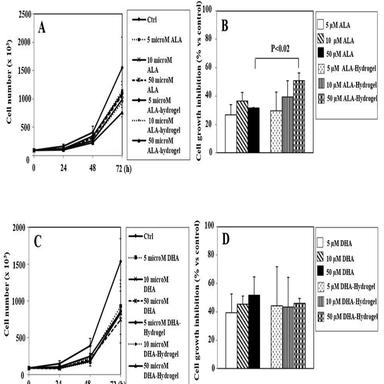
(A) Effect of ALA, in its free form, or delivered by hydrogel at increasing concentrations (5–50 μM) on the growth of HCT116 human colon adenocarcinoma cells evaluated at different time points (24–72 h). (B) Effect of a 72 h treatment with 50 μM ALA, in its free form or delivered by hydrogel, on the growth of HCT116 cells. (C) Effect of DHA, in its free form, or delivered by hydrogel at increasing concentrations (5–50 μM) on the growth of HCT116 human colon adenocarcinoma cells evaluated at different time p